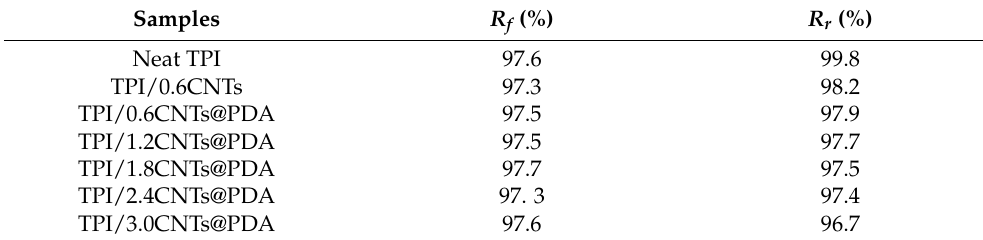
Table 4. Shape-memory performance parameters for TPI